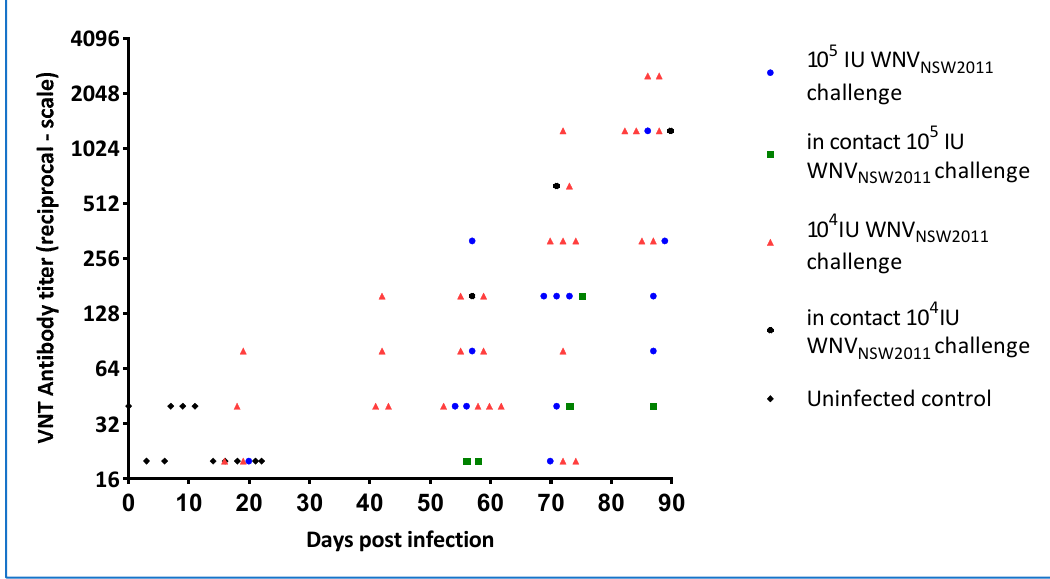
Figure 12. WNV KUN -neutralizing antibody responses in experimentally infected hatchling saltwater crocodiles and in the in-pen contact animals. For the first 21 dpi, each animal was bled every third day. At the later time points (after 40 dpi), all remaining animals were bled on each occasion.